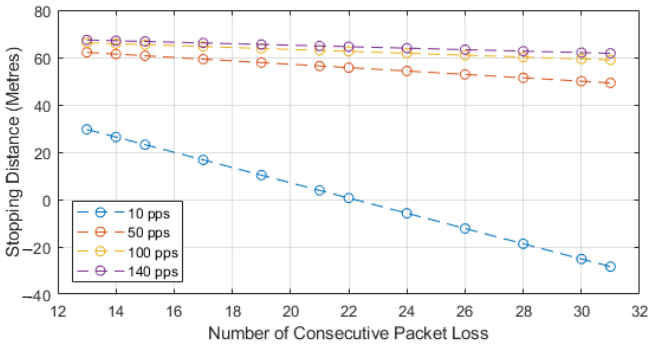
Figure 22. Joint loss—10% density